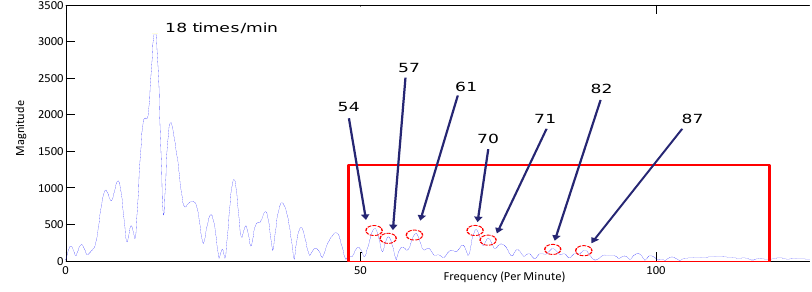
Figure 7. The spectrum of the vital signal.